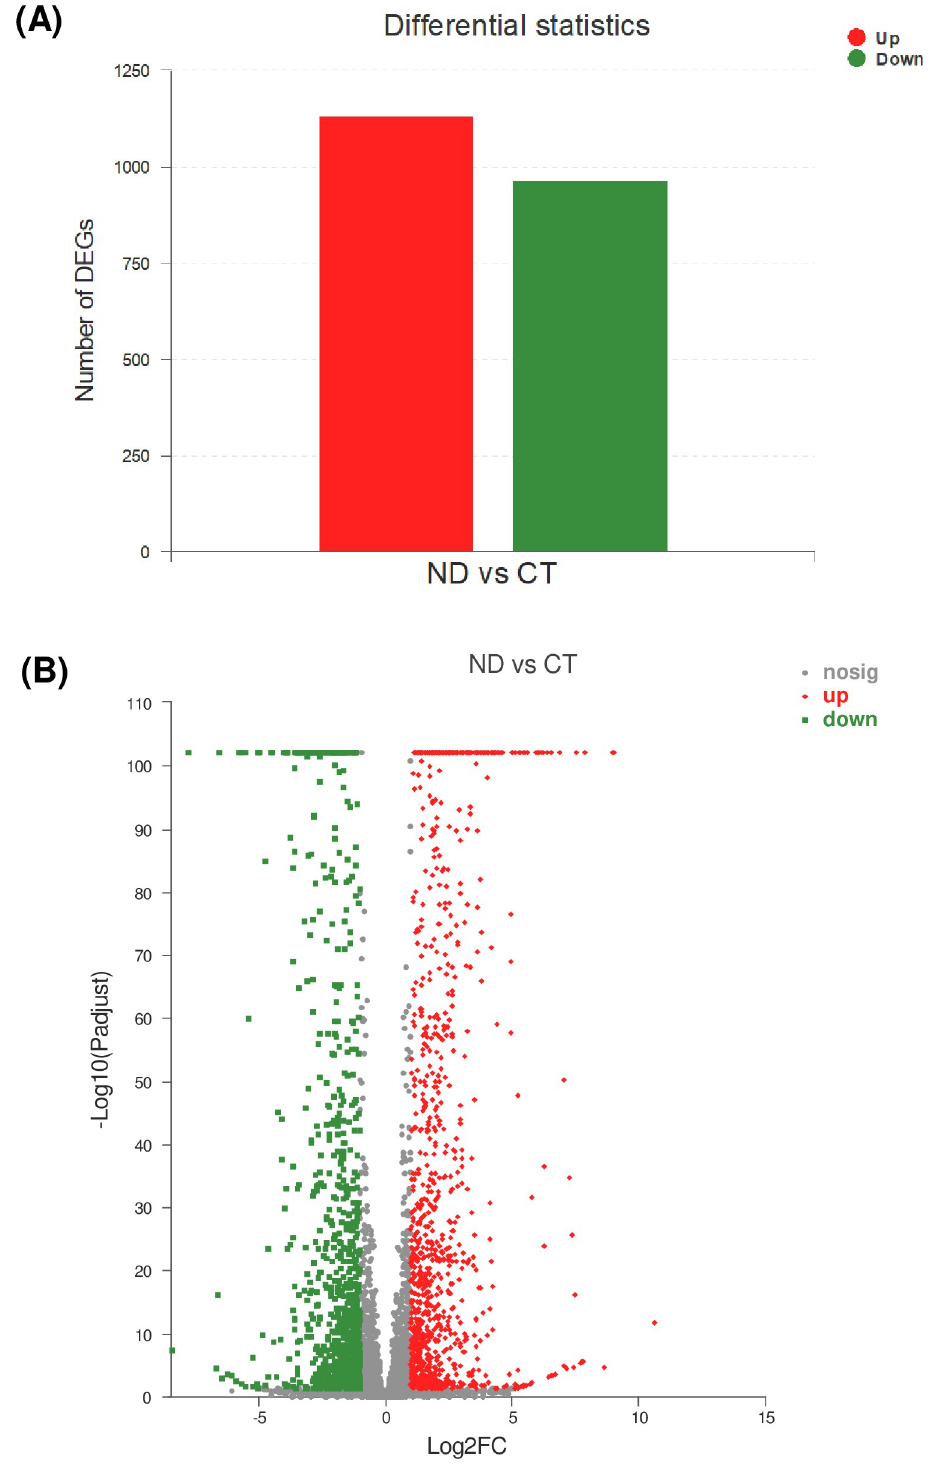
Fig 4. Differential expression unigenes in P . cruentum of two different cultivation conditions. (A) The number of differential expression genes (DEGs) under ND (nitrogen depletion) vs CT (nitrogen repletion). At least 2-fold down- regulation or up-regulation was calculated under nitrogen starvation condition. (B) Volcano plot of the differential gene expression patterns between CT and ND. Reds pots represent up-regulated DEGs, green spots represent down- regulated DEGs, and gray spots represent unigenes that did not change significantly under nitrogen deprivation (ND) treatment. https://doi.org/10.1371/journal.pone.0259833.g004 PLOS ONE | https://doi.org/10.1371/journal.pone.0259833 November18,